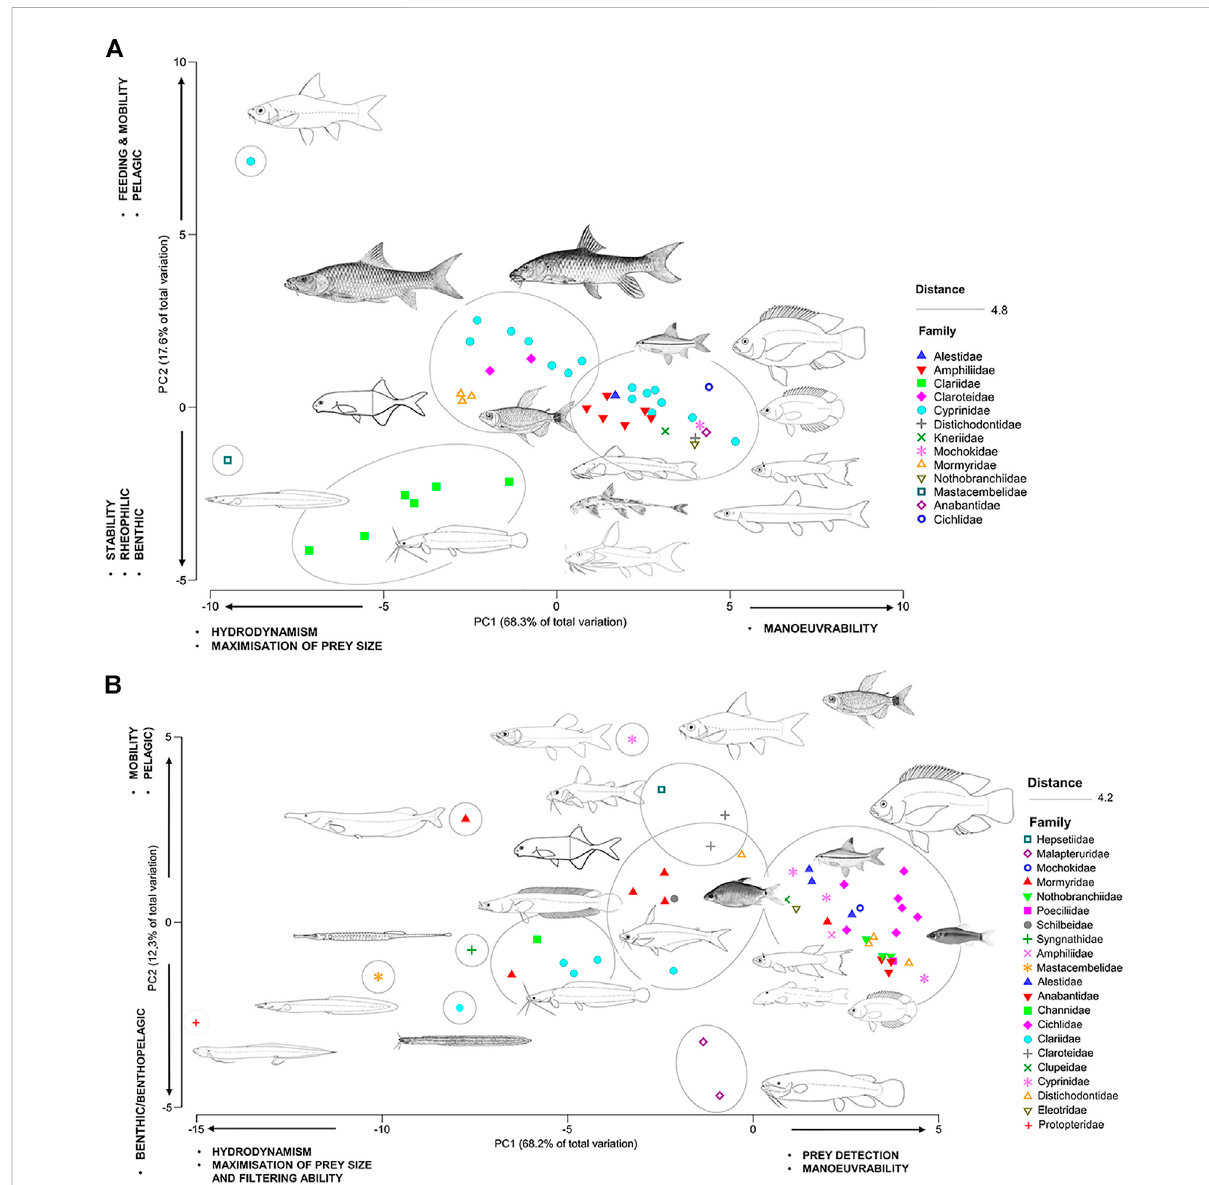
FIGURE 6 Functional traits PCA ordination for (A) Upper basin and (B) Lower basin species showing the position of the fi sh species in two dimensions of functional trait space. Traits used to characterize the two axes had correlation coef fi cients ≥